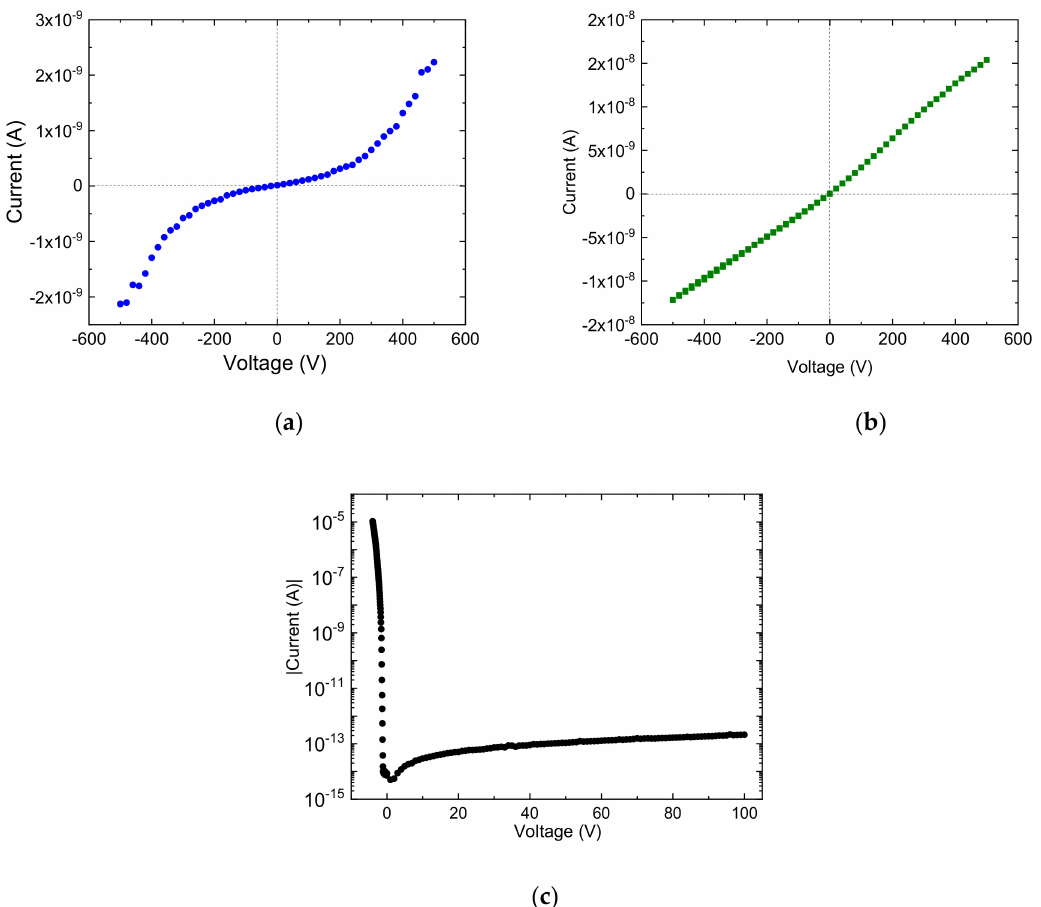
Figure 6. ( a ) I–V characteristics showing the Schottky (double) diode behaviour measured for a diamond detector realized with a 500 µ m thick film and two Pt contacts; ( b ) I–V characteristics showing the ohmic behaviour measured for a diamond detector realized with a 500 µ m thick film and two Ag-Ag metal contacts post-deposition annealed at 600 ◦ C per 1 h in vacuum ( c ) I–V characteristic of the boron-intrinsic diamond (75 µ m thick)—Al (Schottky)